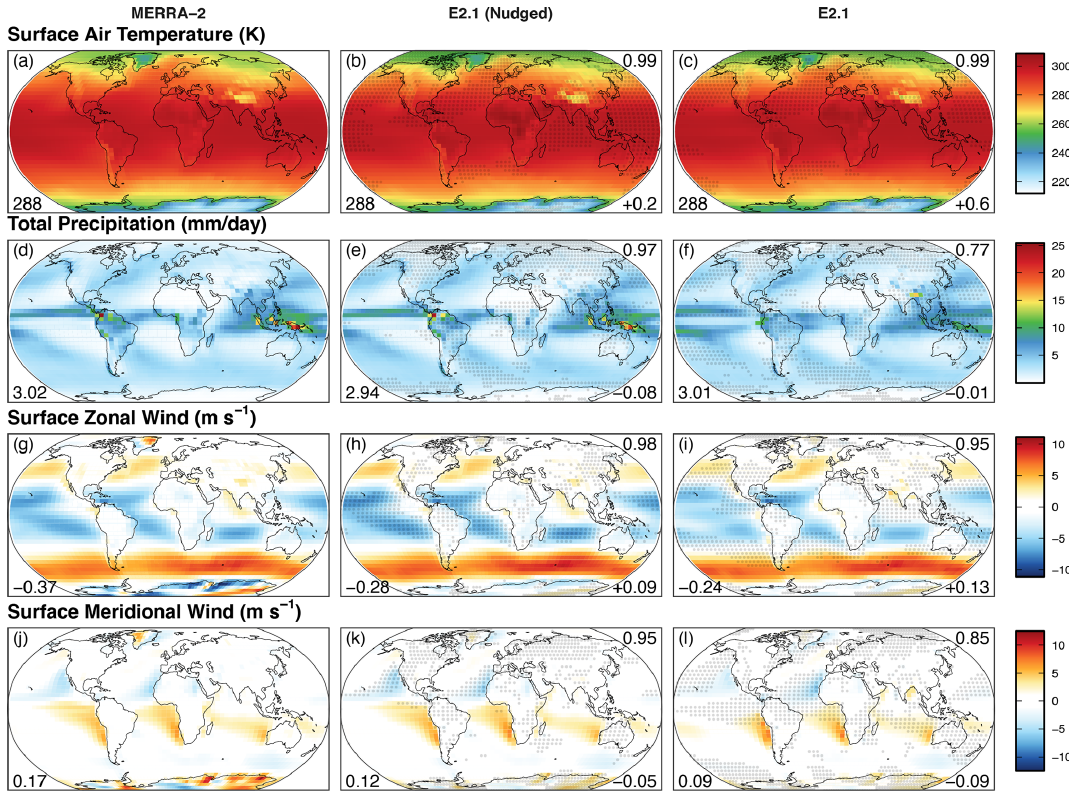
Figure 4. Comparison of present-day surface meteorology. Columns from left to right show annual climatological means for 2005–2014CE in the MERRA-2 reanalysis, our E2.1 simulations with winds nudged to MERRA-2, and our free-running E2.1 simulations. From top to bottom, rows show surface air temperature in K, total precipitation rate in mmd − 1 , the zonal component of the surface wind in ms − 1 , and the meridional component of the surface wind in ms − 1 . Gray dots show where the two E2.1 simulations are statistically different from their MERRA-2 counterparts with respect to interannual variability ( p value < 0.05; n = 10 years). The number in the bottom left shows the global mean value for each panel. The top right number shows the pattern correlation, and the number in the bottom right shows the global mean difference in the E2.1 simulations with respect to